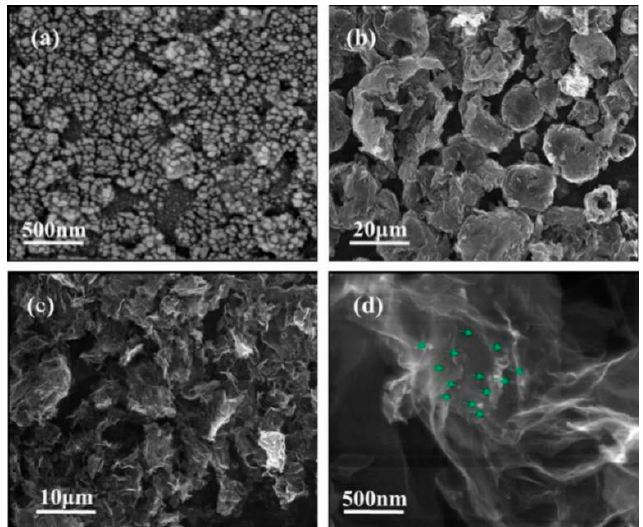
Figure 1. Typical low and high-magnification scanning electron microscopy (SEM) images of ( a ) nano- magnesium silicate hydroxide (MSH) particles, ( b ) crumpled graphene balls (CGB), ( c , d ) MSH/CGB composites.